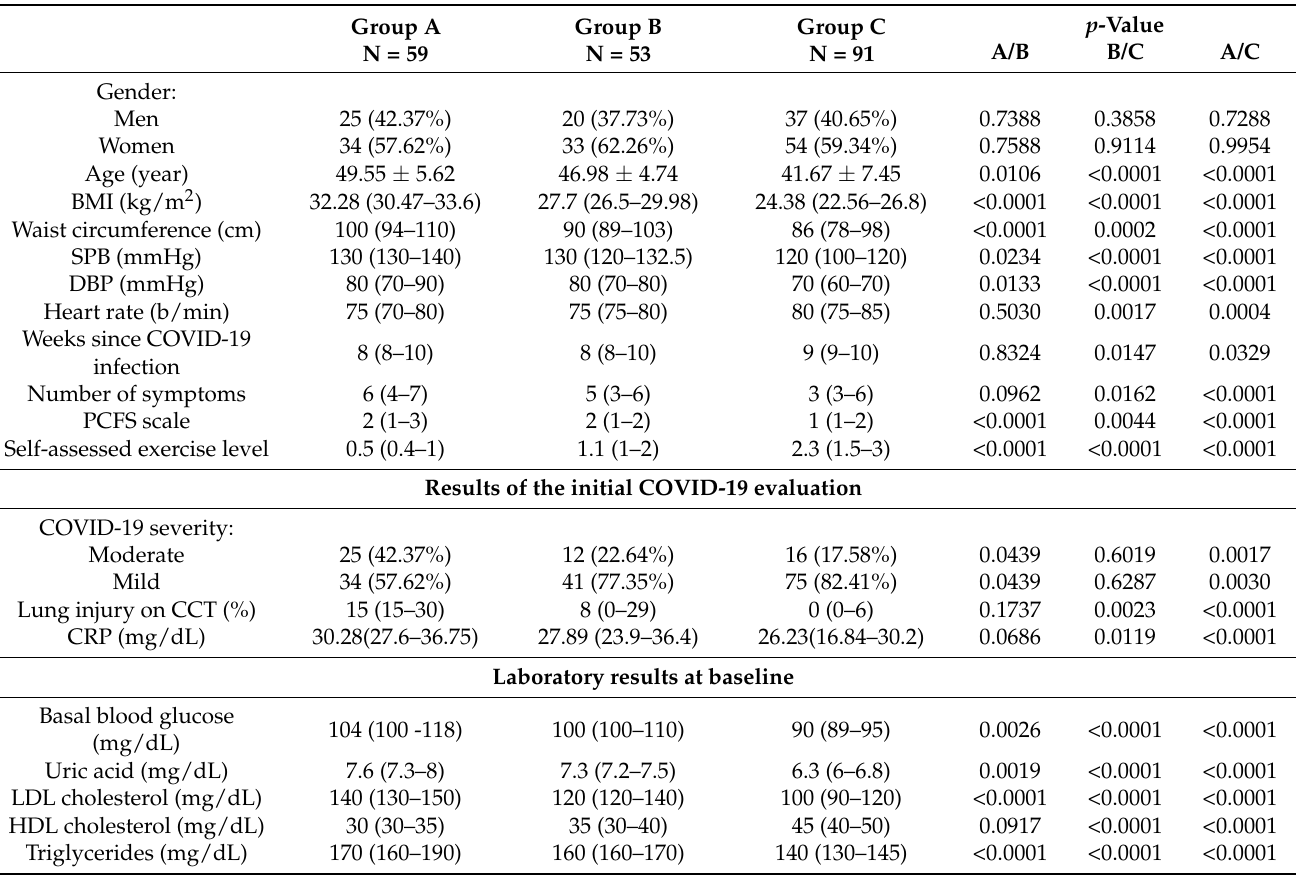
Table 1. Clinical and laboratory characteristics of the study